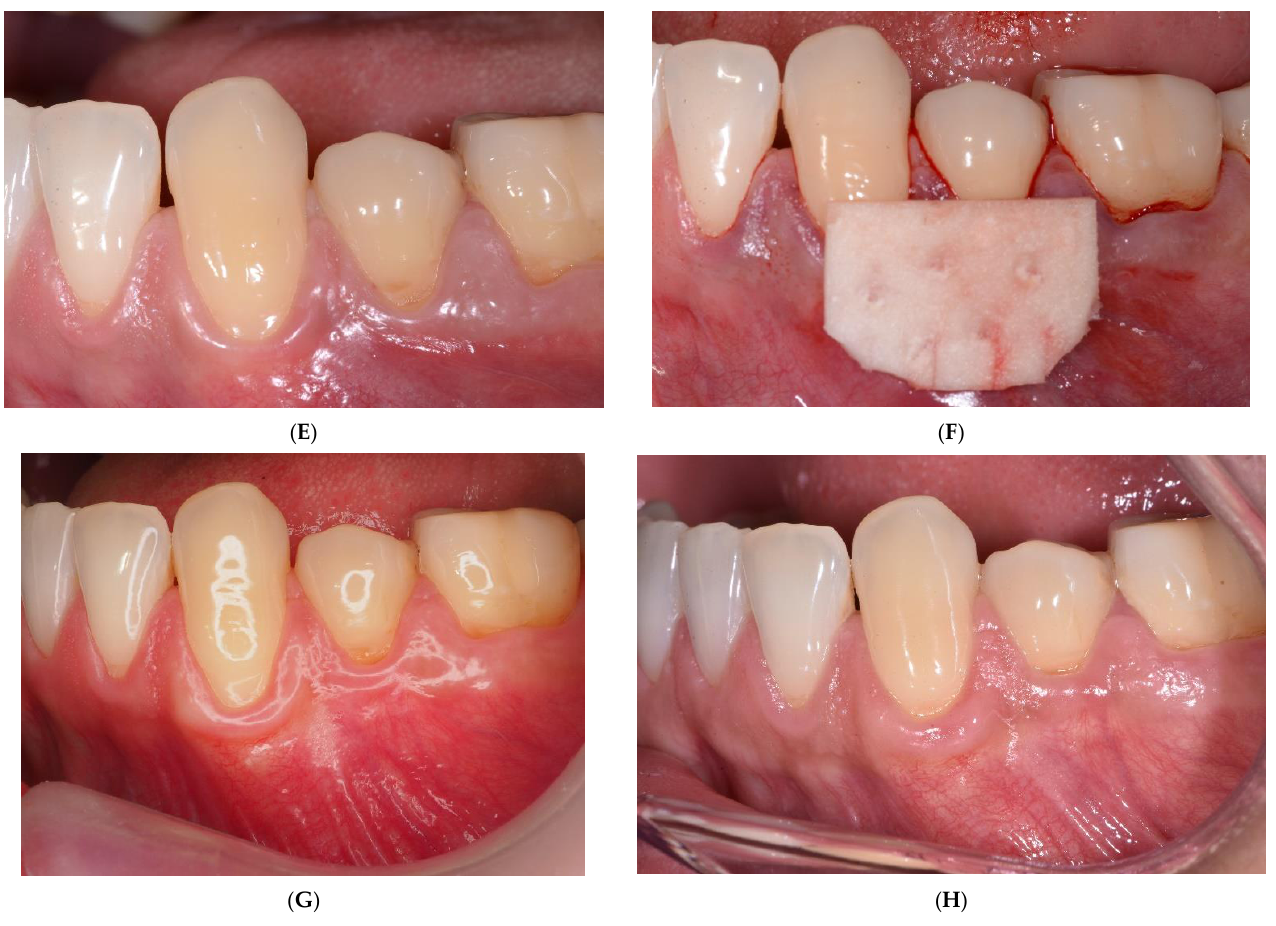
Figure 1. ( A ) Baseline SCTG side: the canine and the second premolar with recessions on the right side in the lower jaw; ( B ) position of the SCTG; ( C ) postoperative (12 months) view; ( D ) postoperative (5 years) view; ( E ) baseline CM side: the canine and the second premolar with recessions on the left side in the lower jaw; ( F ) CM position; ( G ) postoperative (12 months) view; ( H ) postoperative (5 years) view.